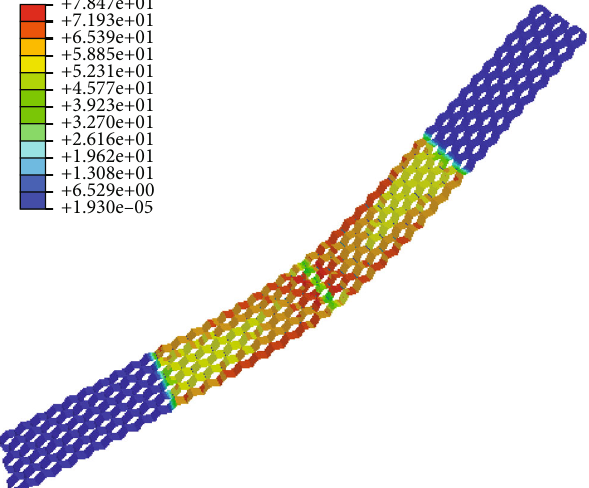
Figure 10: Stress (( S , miss/MPa)) nephograms of lower panel belong to actual model.